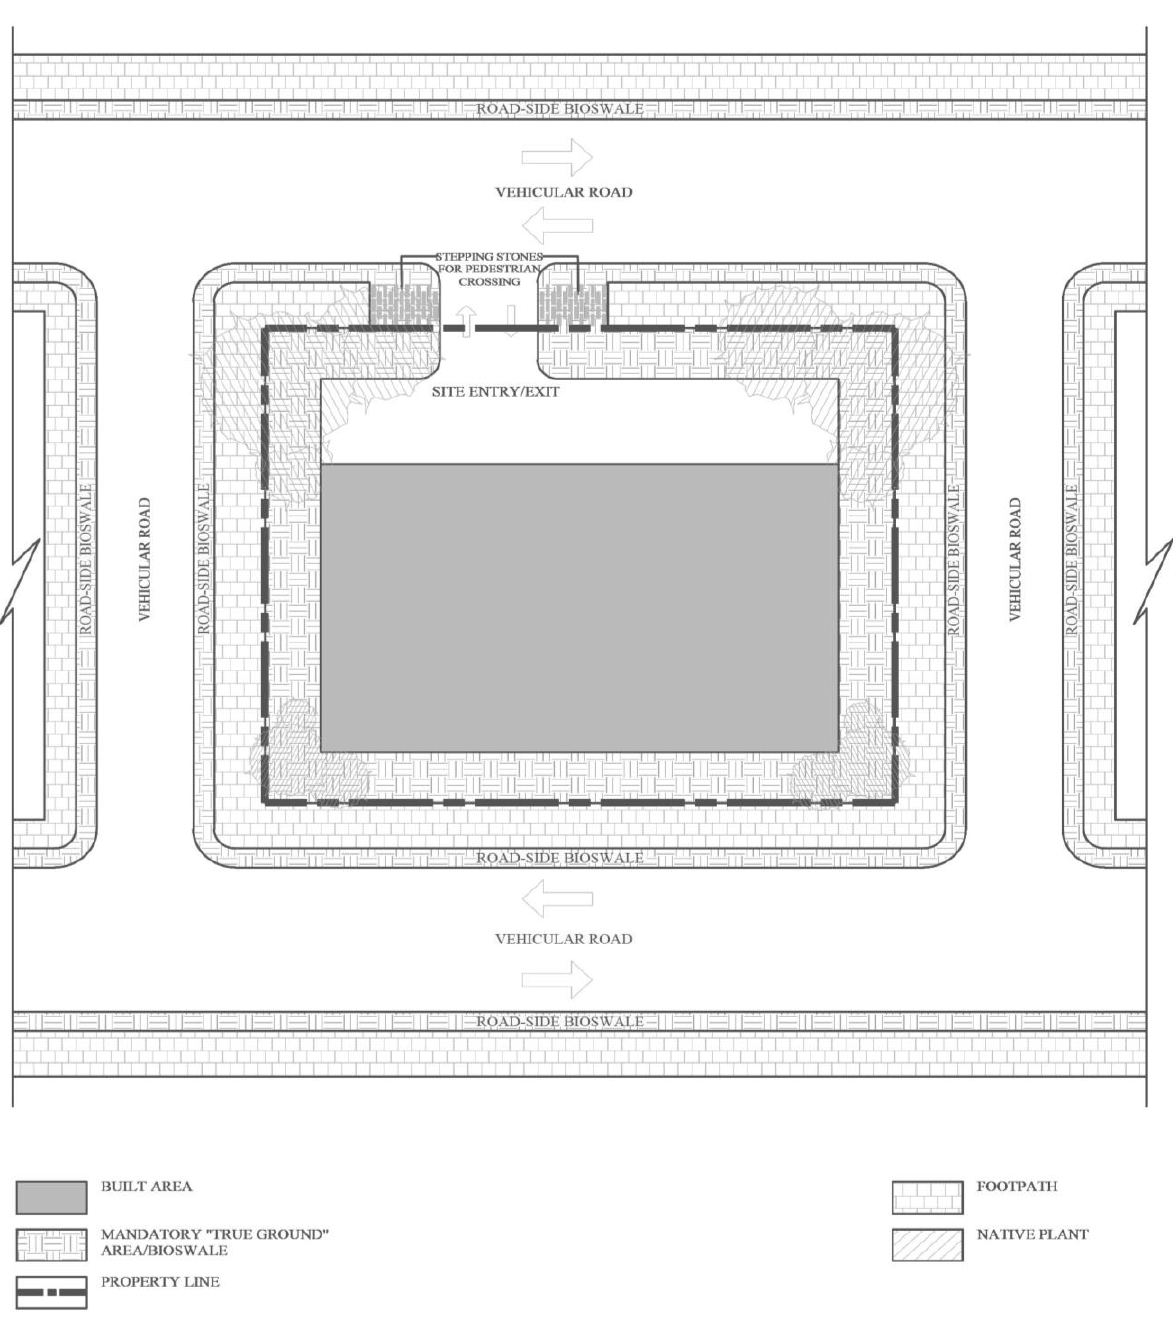
Figure 5: A conceptual diagram showing how the mandatory soakable true ground can be connected with the roadside